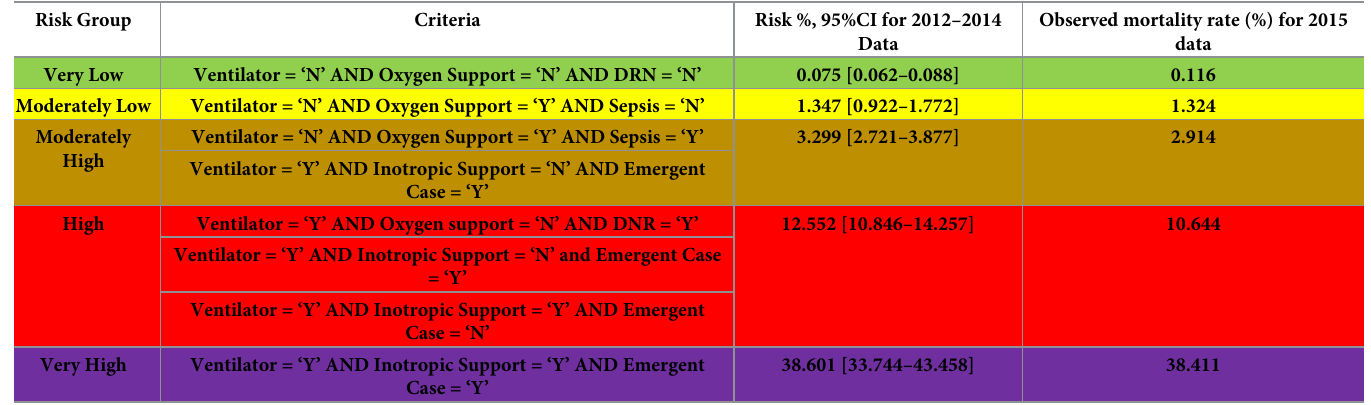
Table 4. Surgical mortality risk groups for children.